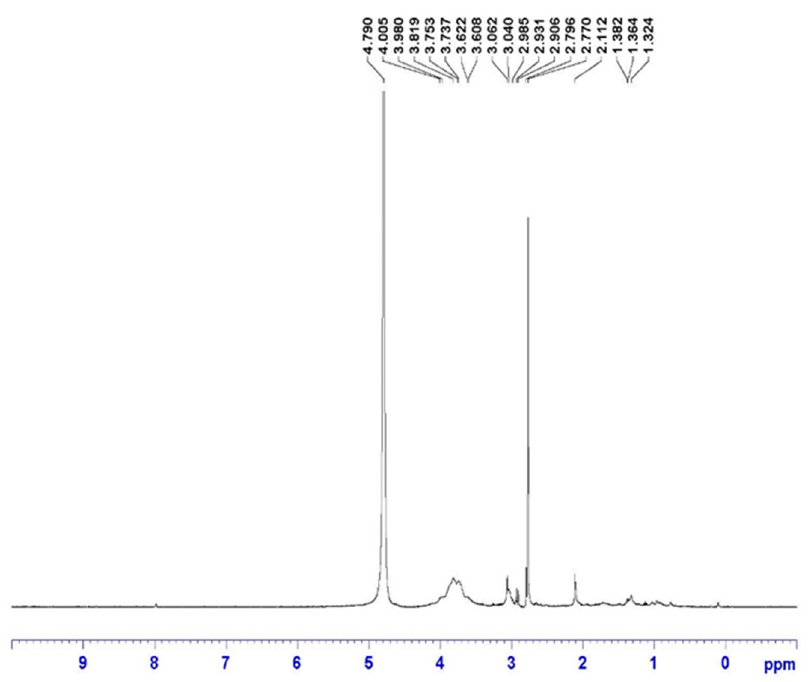
Figure 9. Proton NMR spectrum of galactose and cholic acid conjugated derivative 2 in D 2 O.